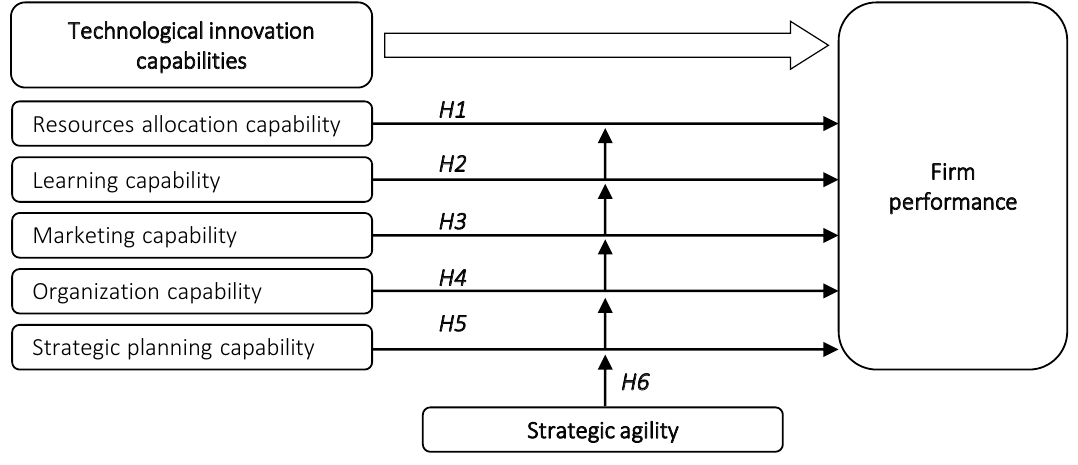
Figure 1. Research